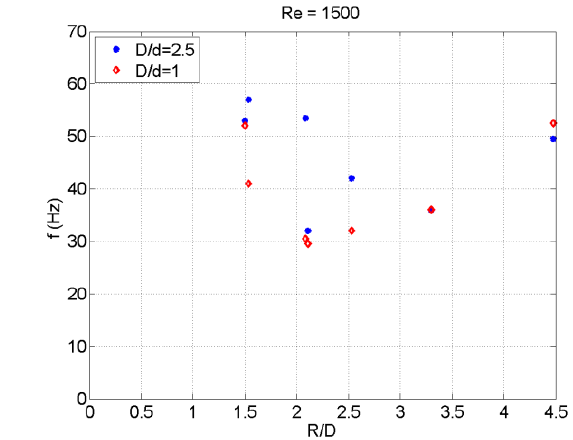
Figure 10. Relationship between the frequency and the pitch distance for Re